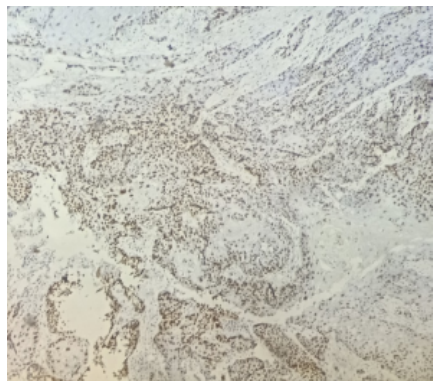
Figure 2. Photomicrograph of P53 immunohistochemical stain showing nuclear positivity (in 10x view)